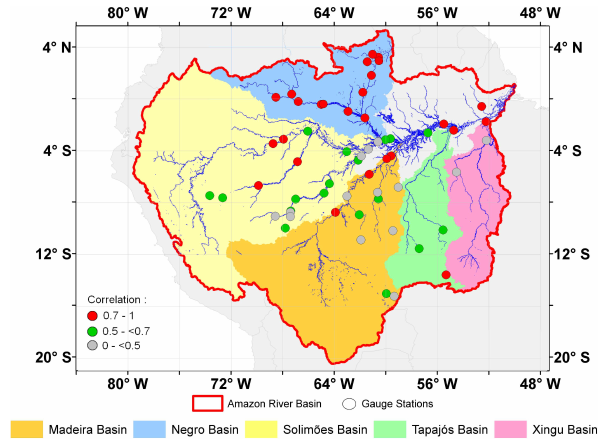
Fig. 1. Amazon River watershed with its main sub-basins. Loca- tion of the in situ river stages is indicated by dots. The red dots are the stations used in the reconstruction over 1980–2008 and cor- respond to a correlation coefficient ≥ 0.7 with GRACE TWS and in-situ level data over 2003–2008. The stations with a correlation coefficient in the range (0.5–0.7) are in green dots and in grey dots for a correlation coefficient <